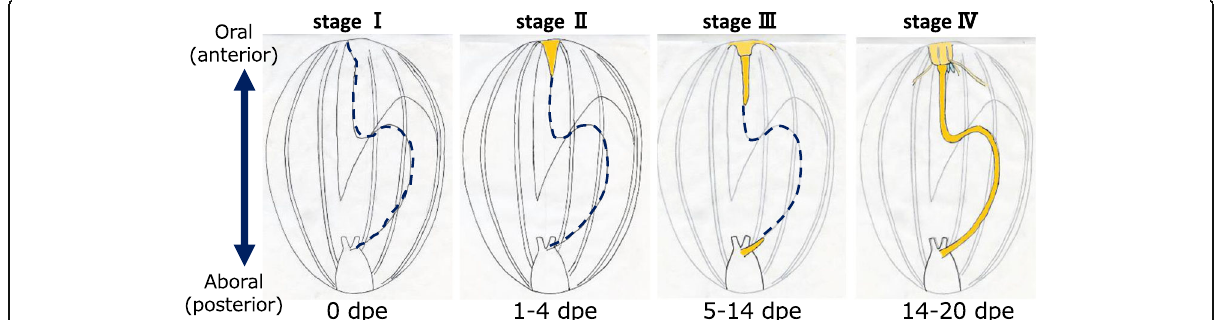
Fig. 3 Stages of regeneration. Based on the internal morphology of regenerating animals, we defined four stages of regeneration, stages I to IV, and schematic diagrams of each are shown. Blue broken line: the edge of mesentery without regenerating tissues; yellow colored area: regenerating tissues (gut